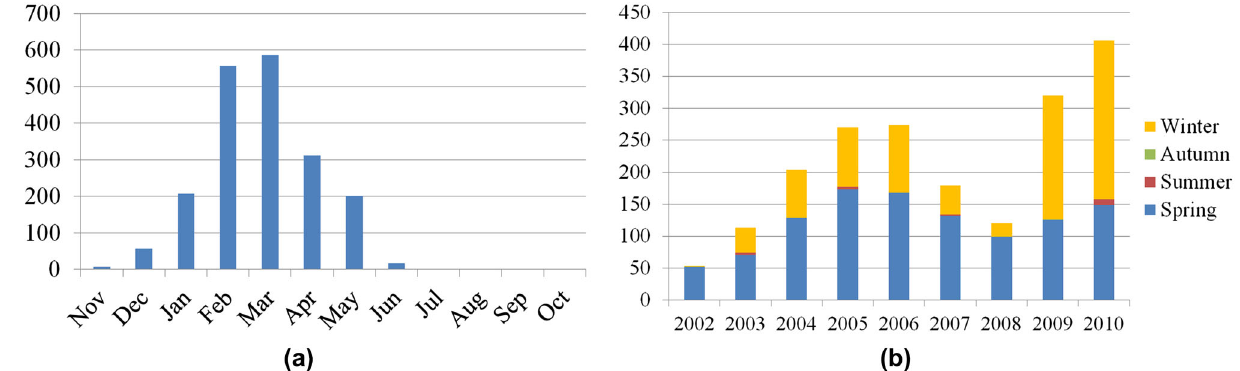
Fig. 2 Monthly ( a ) and seasonal and yearly ( b ) variations of the wildfire ignition number in Yunnan